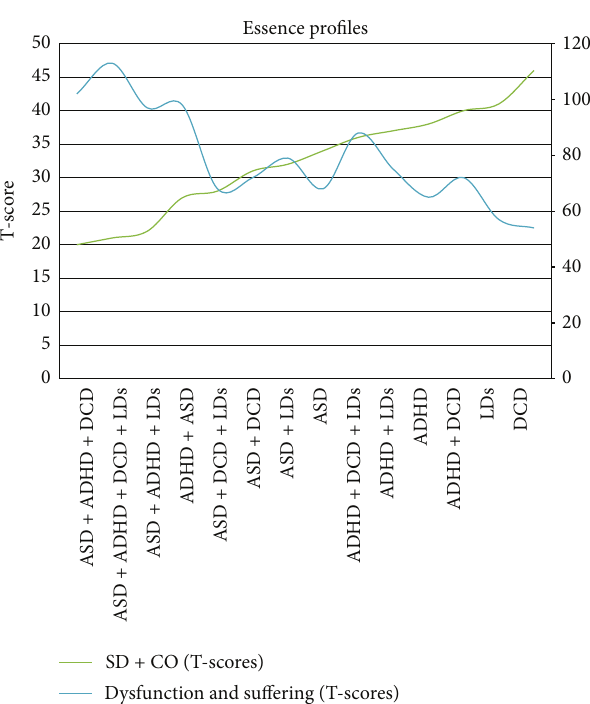
Figure 1: The graph shows means in SD + CO and dysfunction and suffering (T-scores) as a function of ESSENCE profiles. SD + CO: left-axis scale; dysfunction and suffering: right-axis scale.